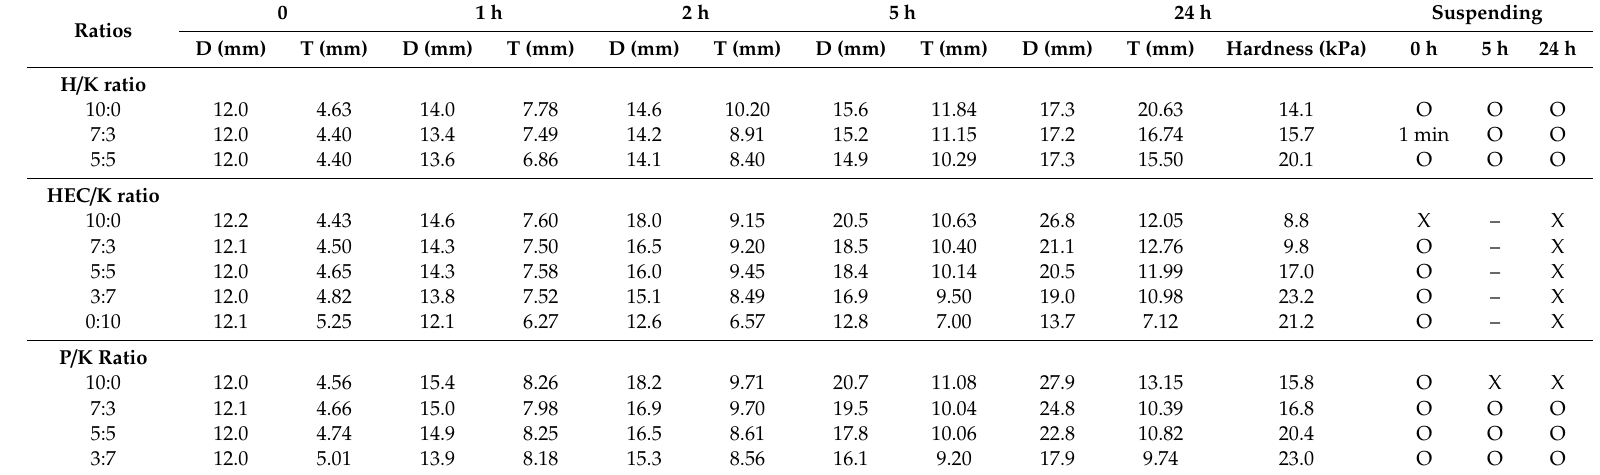
Table 3. Swelling and floating abilities of three polymers (HPMC 90SH 100K, HEC 250HHX, and PEO 7000K) with various ratios of Kollidon SR tableted at 0.5 tons of compression